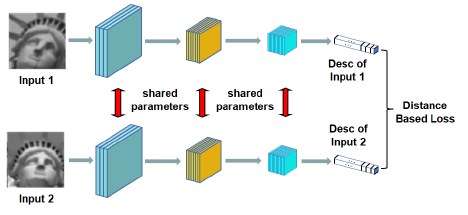
Figure 2. Siamese CNN used for descriptor learning.